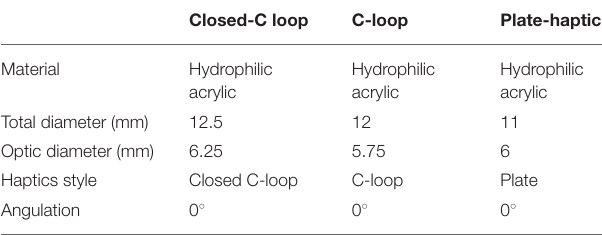
TABLE 1 | Characteristics of the three types of intraocular